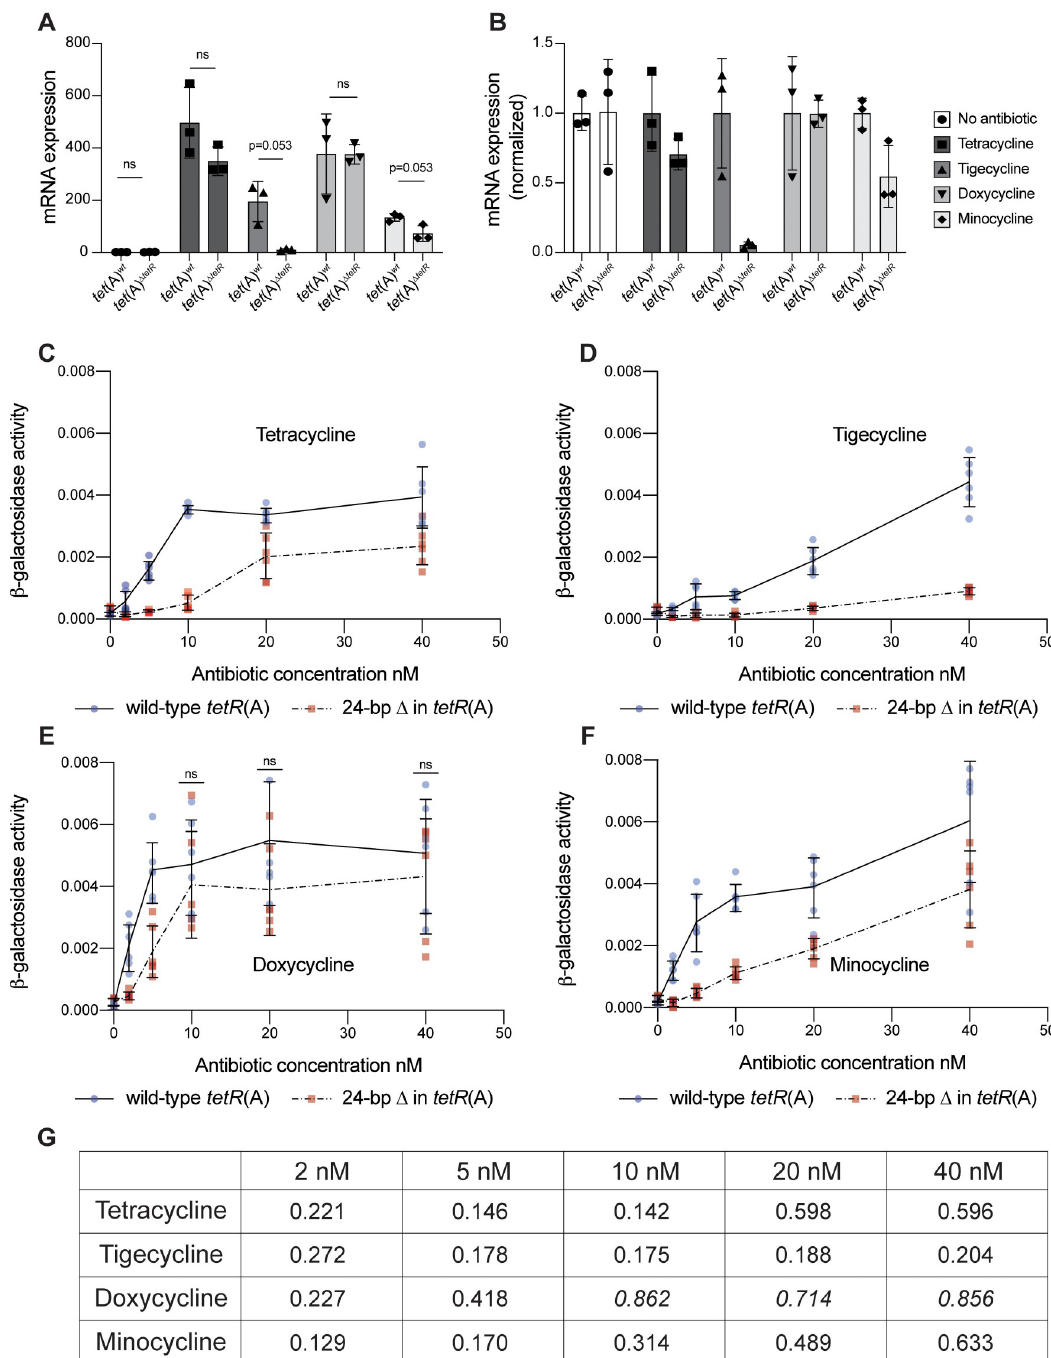
Fig 4. Expression and induction of tetA (A) in response to tetracycline antibiotics. ( A, B ) mRNA expression levels of tetA (A) for tet (A) wt and tet (A) Δ tetR ( A ) and mRNA expression levels normalised to expression of tet (A) wt in response to induction by different tetracycline antibiotics at concentrations 1/10th the MIC of the strain carrying tet (A) wt ( B ). The strains used are isogenic and only differ by the nature of the tet (A) allele. Three biological replicates performed for each allele and antibiotic, mean (bars) and SD shown. P -values shown in panel A when p < 0.1 (Welch t tests). ns; no significant statistical difference. ( C–F ) Expression of TetA(A) in presence of TC ( C ), TGC ( D ), DO ( E ), and MI ( F ) by β -galactosidase assays ( tetA (A)- lacZ translational fusions). Induction by wild-type tetR (A) (blue circles, solid lines) or tetR (A) with 24-bp deletion (red boxes, dashed lines) were compared in otherwise isogenic strains. Unless stated otherwise (ns; not significant), significant differences in expression were detected between the two tetR (A) alleles (unpaired t tests performed for the two alleles at each concentration, with correction for multiple t tests using the